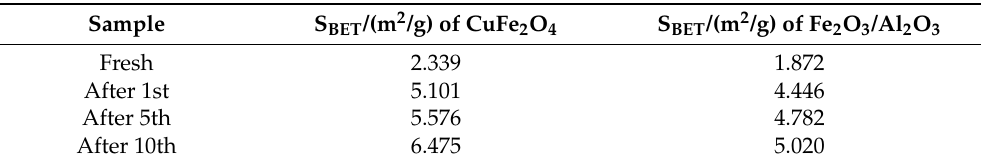
Figure 13. XRD patterns of ( a ) Fe 2 O 3 /Al 2 O 3 and ( b ) CuFe 2 O 4 in different cyclic experiments. Table 2. BET (Brunauer, Emmett, and Teller) specific surface area of CuFe 2 O 4 and iron-based OC after cyclic experiment.